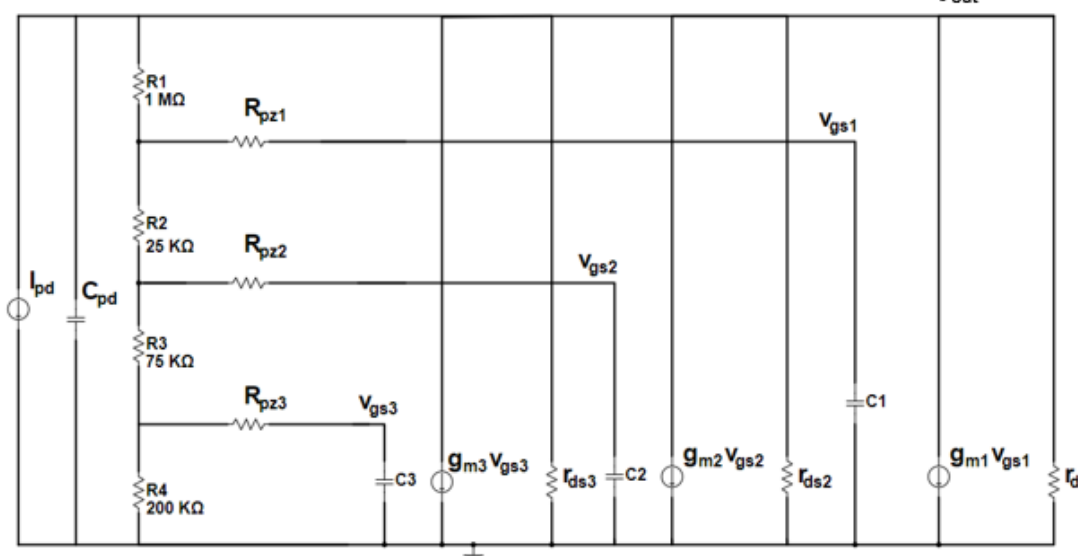
Figure 2. The small signal model of the photocurrent sensory circuit.